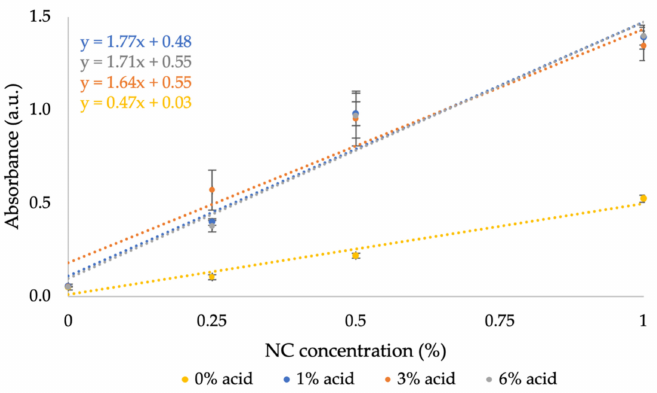
Figure 3. NC absorbance at λ = 400 nm in varying sulfuric acid